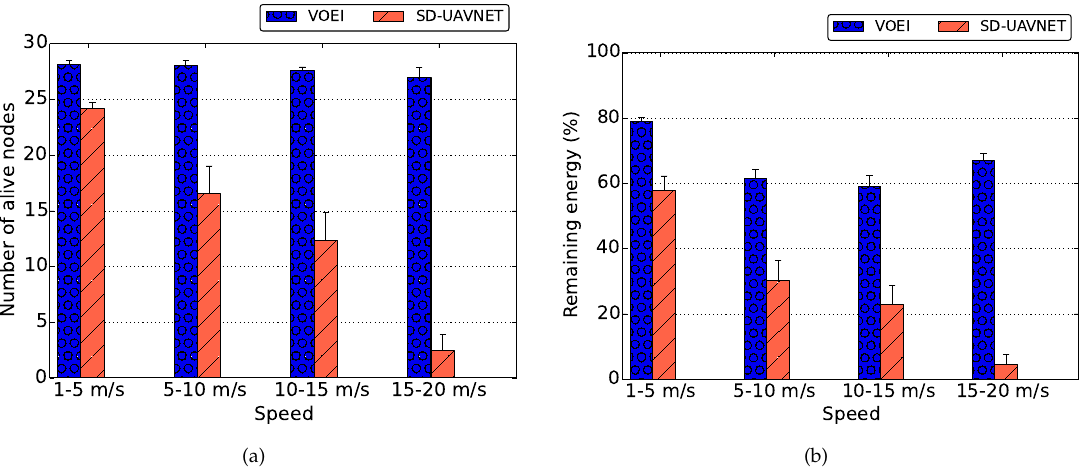
Figure 5. Remaining energy and number of live UAVs during the entire simulation for UAVs flying with different speed limits. ( a ) Nodes of live UAV; ( b ) Remaining